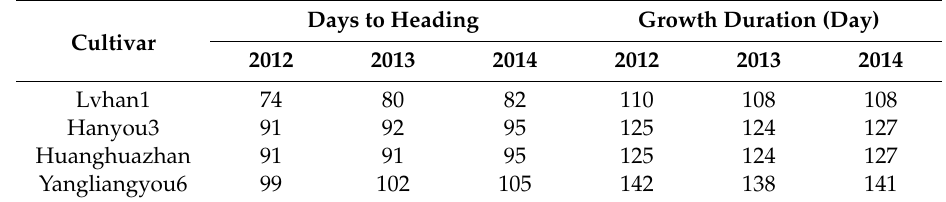
Table 2. Days to heading and growth duration of four tested cultivars under aerobic cultivation in all three years.